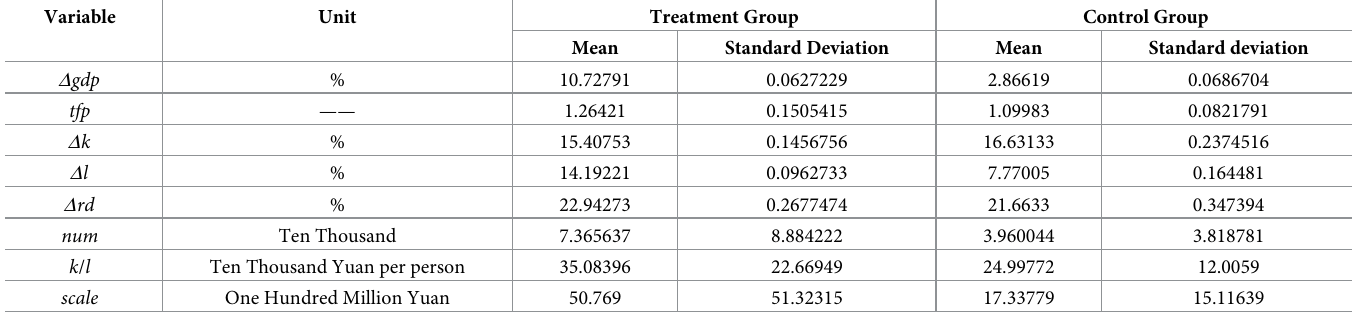
Table 4. Descriptive statistics of